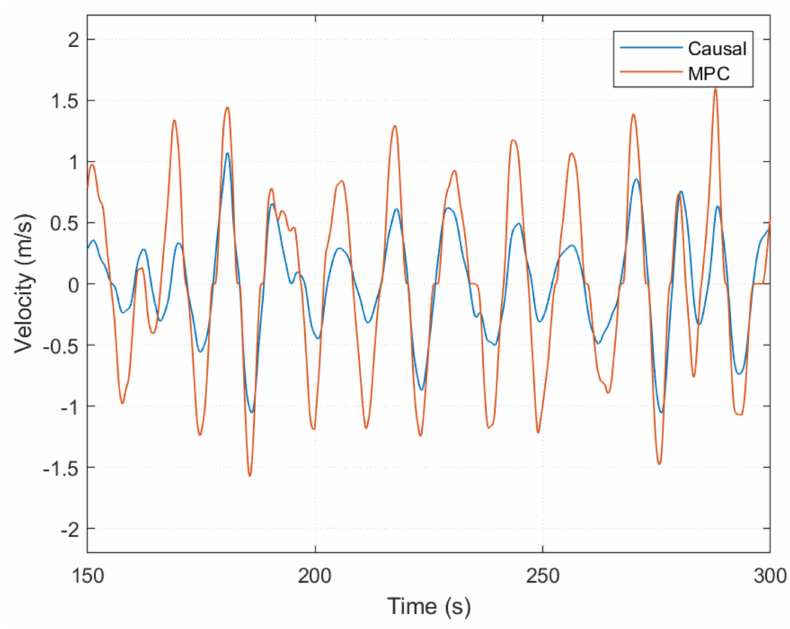
Figure 14. Comparison of velocity response using causal control vs. MPC for an input wave with Hs = 1.0 m, Tp = 15 s.